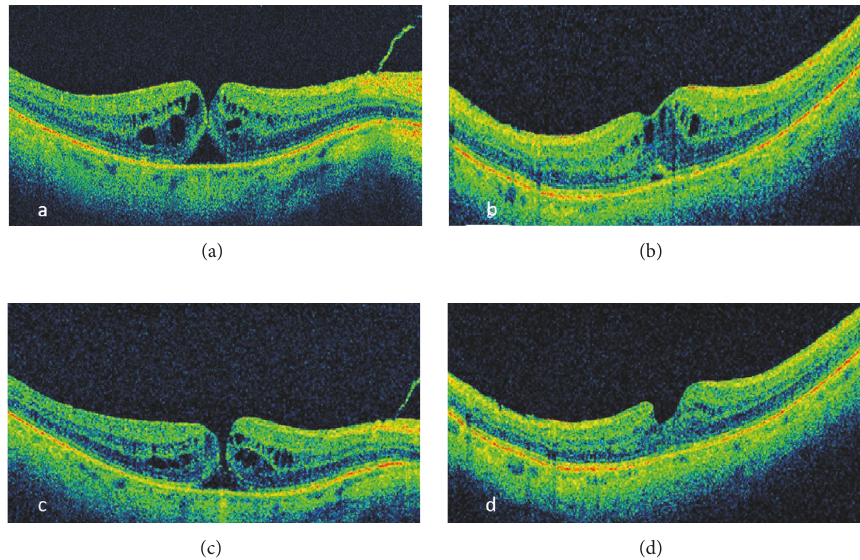
Figure 2: Optical coherence tomography showing (a) tiny full thickness macular hole, (b) first closure of macular hole, (c) reopening of macular hole, and (d) reclosure of macular